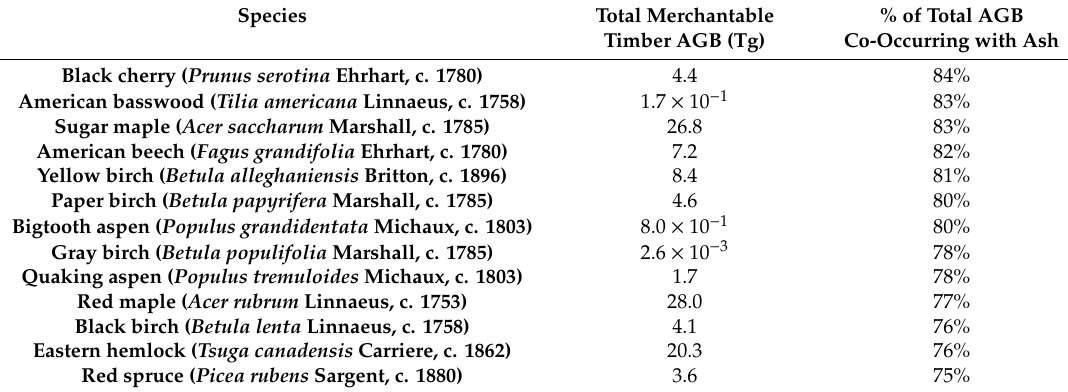
Table 1. Tree species that most commonly co-occur on parcels with ash (Fraxinus spp.) for all parcels in the Connecticut River Watershed. Total merchantable timber is the total amount of species-specific aboveground biomass (AGB). The percent of total AGB that co-occurs with ash represents the amount of that species that occurs on parcels with ash; e.g., 84% of all black cherry in the Connecticut River Watershed occurs on parcels with